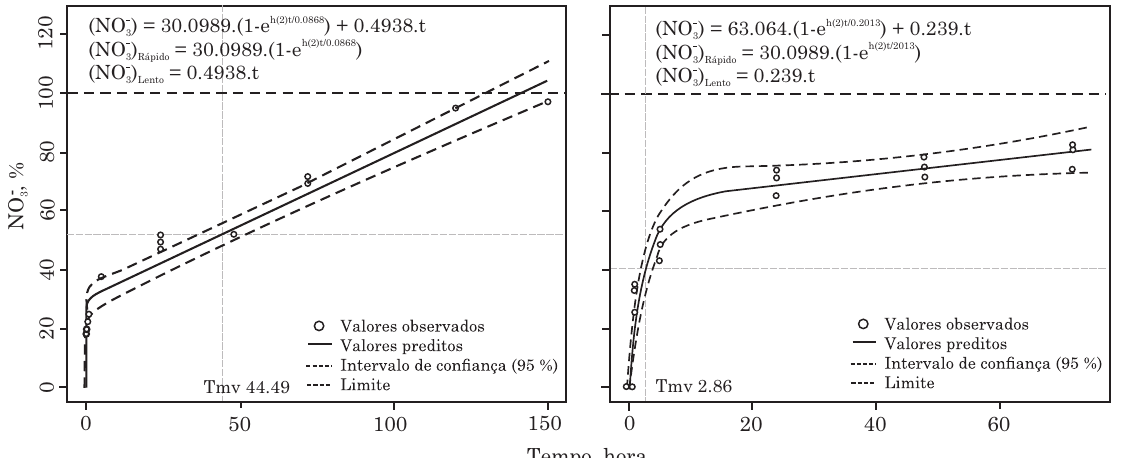
Figura 2. Curvas de liberação de nitrato em (a) solução de NaHCO 3 tamponado a pH 6,5 em 150 h e (b) solução em água em 72